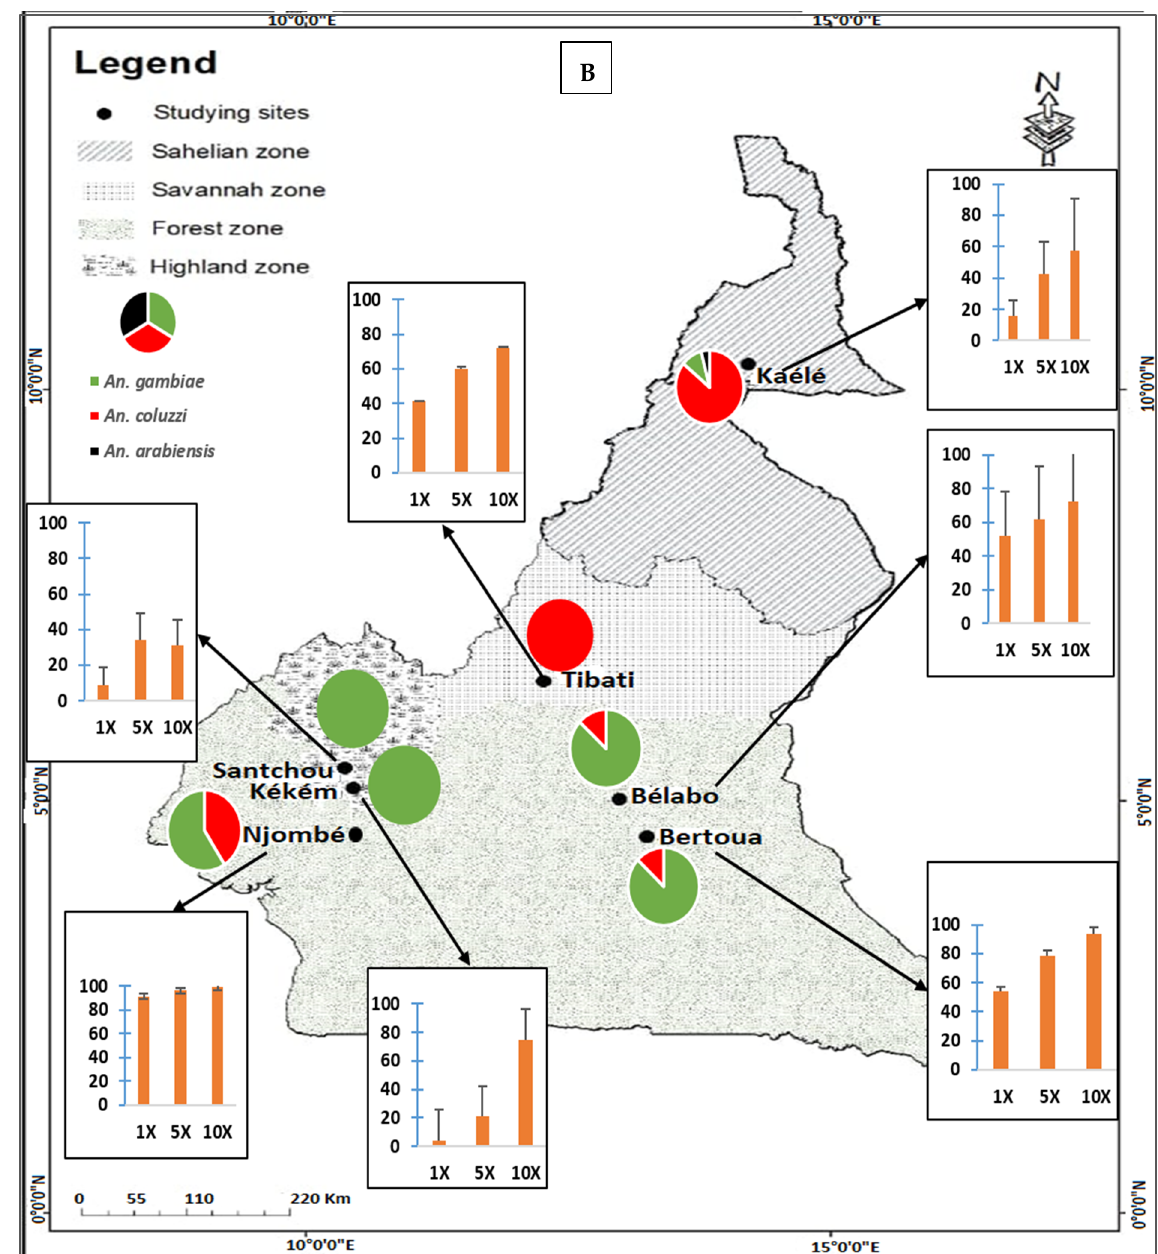
Figure 3. Resistance intensity of An. gambiae (s.l.) populations to permethrin ( A ) and deltamethrin ( B ) in the different study sites in Cameroon. (Permethrin (1×, = 0.75%, 5×, = 3.75%, 10×, = 7.5%) and deltamethrin (1×, = 0.05%, 5×, = 0.25%, 10×, = 0.5%)).